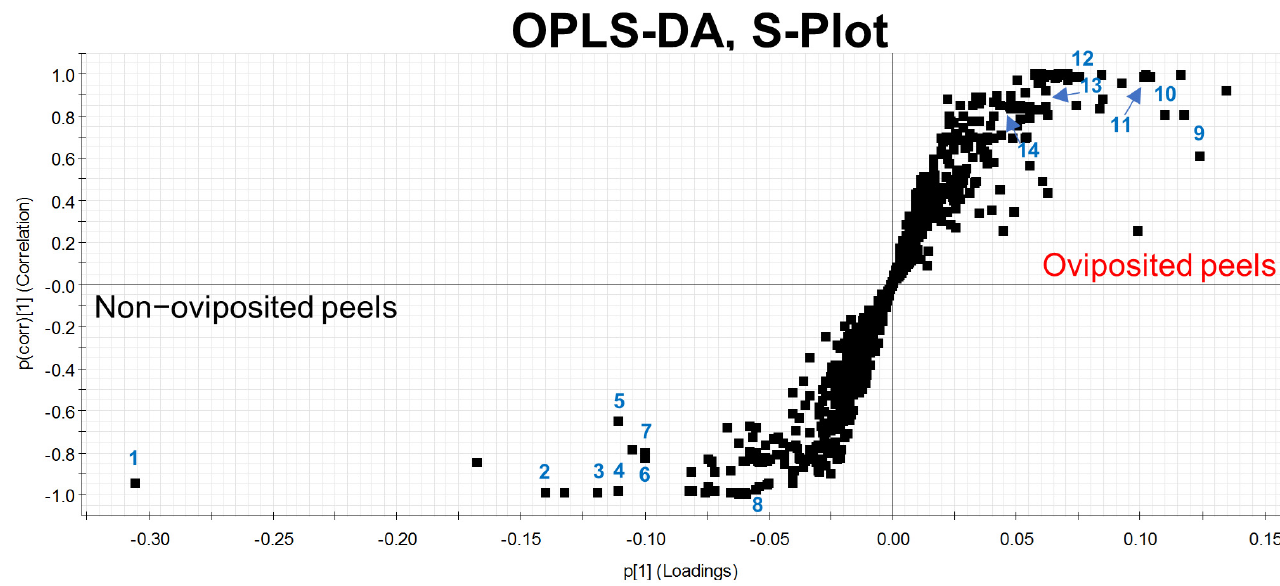
Figure 5. S-Plot generated through a discriminant analysis (OPLS-DA) depicting the peel of “Criollo” mangos into which A. obliqua females had not inserted any eggs (lower left part) versus mango peels used by females as oviposition substrates (pooled samples in both cases). The numbers indicate the position of the chemical markers shown in Table